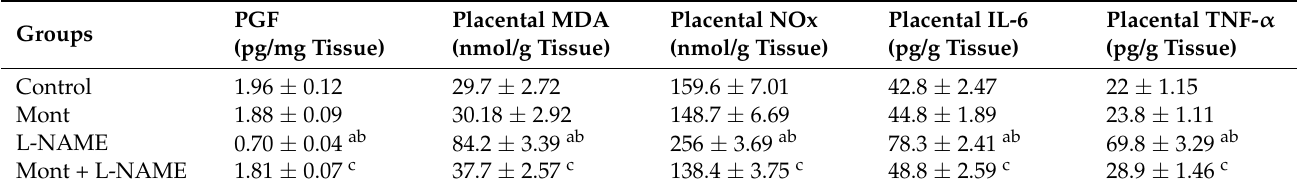
Table 1. Effect of montelukast on placental parameters in a pre-eclampsia model in